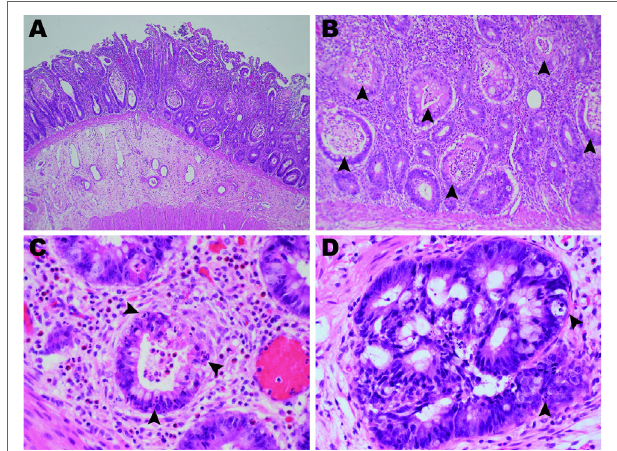
FigUre 2 | Photomicrographs of the ileum and colon (hematoxylin and eosin). (a) The terminal ileum of patient 1 showed erosion, severely inflamed mucosa, and a lack of Peyer’s patches (2 × objective). (B) Widespread crypt abscesses (arrowheads) were noted in association with crypt destruction (10 × objective). (c) The lamina propria was infiltrated by neutrophils and eosinophils with few lymphocytes. Apoptotic bodies (arrowheads) were frequently found in the crypt epithelia (40 × objective). (D) The colon mucosa of patient 2 showed marked crypt epithelial hyperplasia and frequent apoptosis